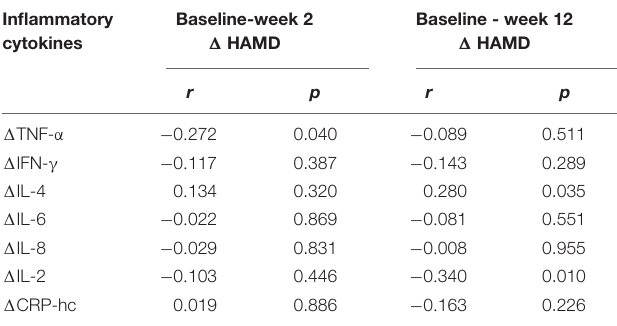
TABLE 5 | Correlations between decreased HAMD score and decreased serum levels of inflammatory cytokines before and after TMS treatment in patients with